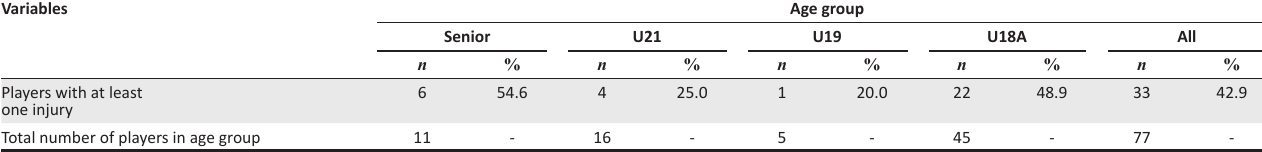
Total number of players in age group